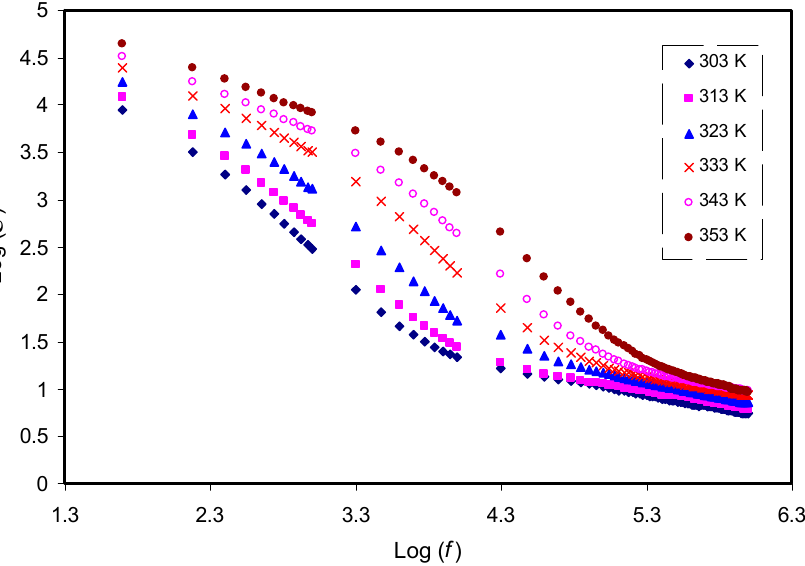
Figure 5. Frequency dependence of dielectric constant ( ε′ ) at selected temperatures for the CS: POZ: MgTf system. Noticeably, the dielectric constant rises with temperature rise.